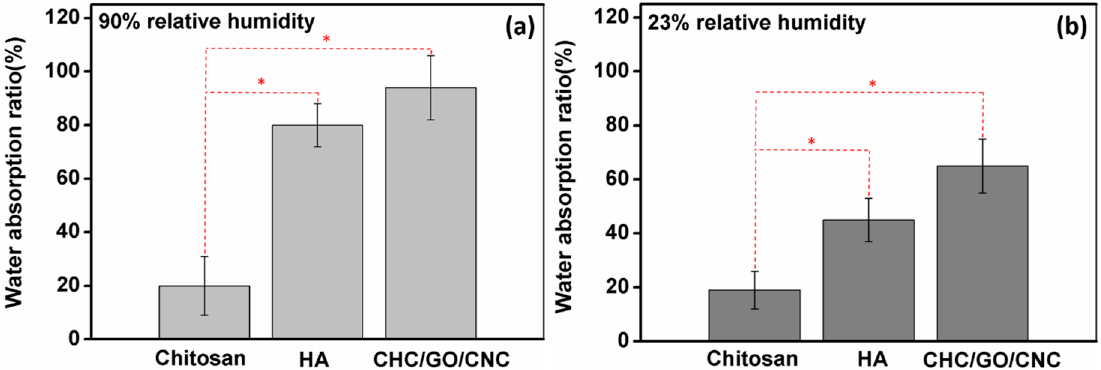
Figure 7. Water absorption ability of pristine chitosan (CS), hyaluronic acid (HA), and the nanocomposite hydrogel (CHC/GO/CNC) at the relative humidity of ( a ) 90% and ( b ) 23% . * The statistical analysis (Student’s t-test) showed a significant difference ( p < 0.05) between the two observed groups (chitosan with HA and CHC/GO/CNC, respectively) at the relative humidity of ( a ) 90% and ( b ) 23%.